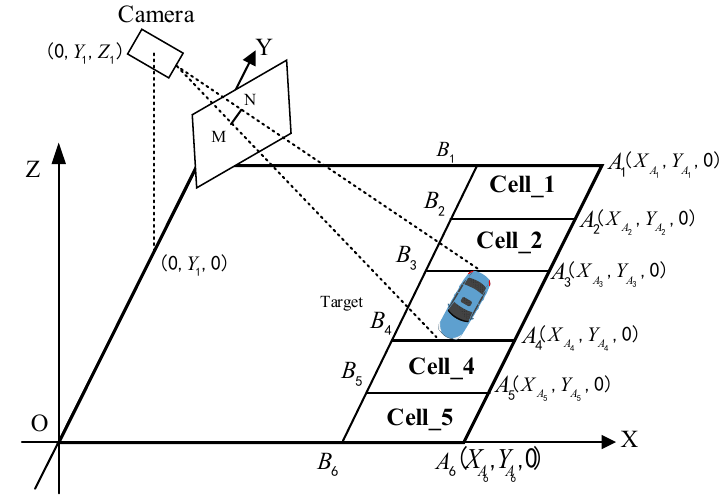
Figure 2. Cell-based scene segmentation.